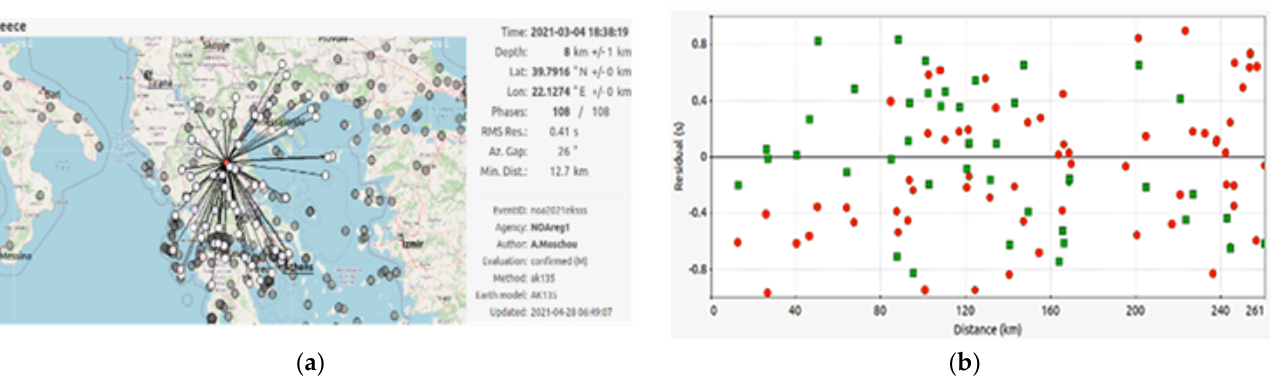
Figure 8. ( a ) Azimuthal distribution of the stations used to calculate the epicenter of the 4 March 2021 (18:38:19.19, UTC) and the characteristics of the solution; ( b ) graph of the distance (km)–residual (s) stations. The green squares represent the stations where only vertical components (P-waves) were used, while the red circles represent the stations where vertical and horizontal components (P-waves and S-waves) were used.